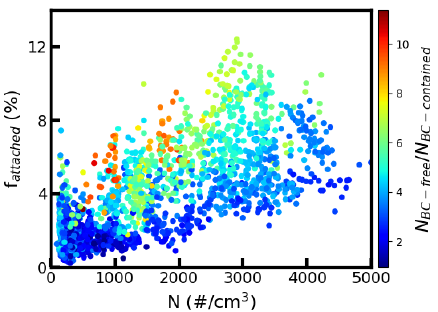
Figure 9. The number fractions of the attached BC aerosols un- der different total aerosol number concentrations for the CP sites. The filled colors represent the ratios between the BC-fee aerosol number concentrations to the BC-containing aerosol number con-